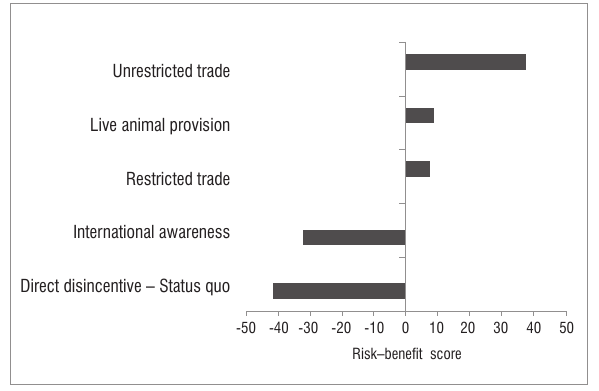
Figure 3. Relative comparison of risks and benefits for five evaluated management strategies to curb rhino poaching in South Africa. Negative scores are indicative of risks outweighing benefits, while positive scores indicate strategies in which benefits outweigh